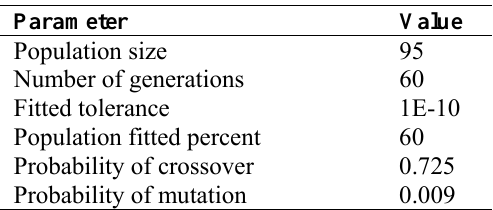
Table 1. Best GEN-2 2 Parameters List